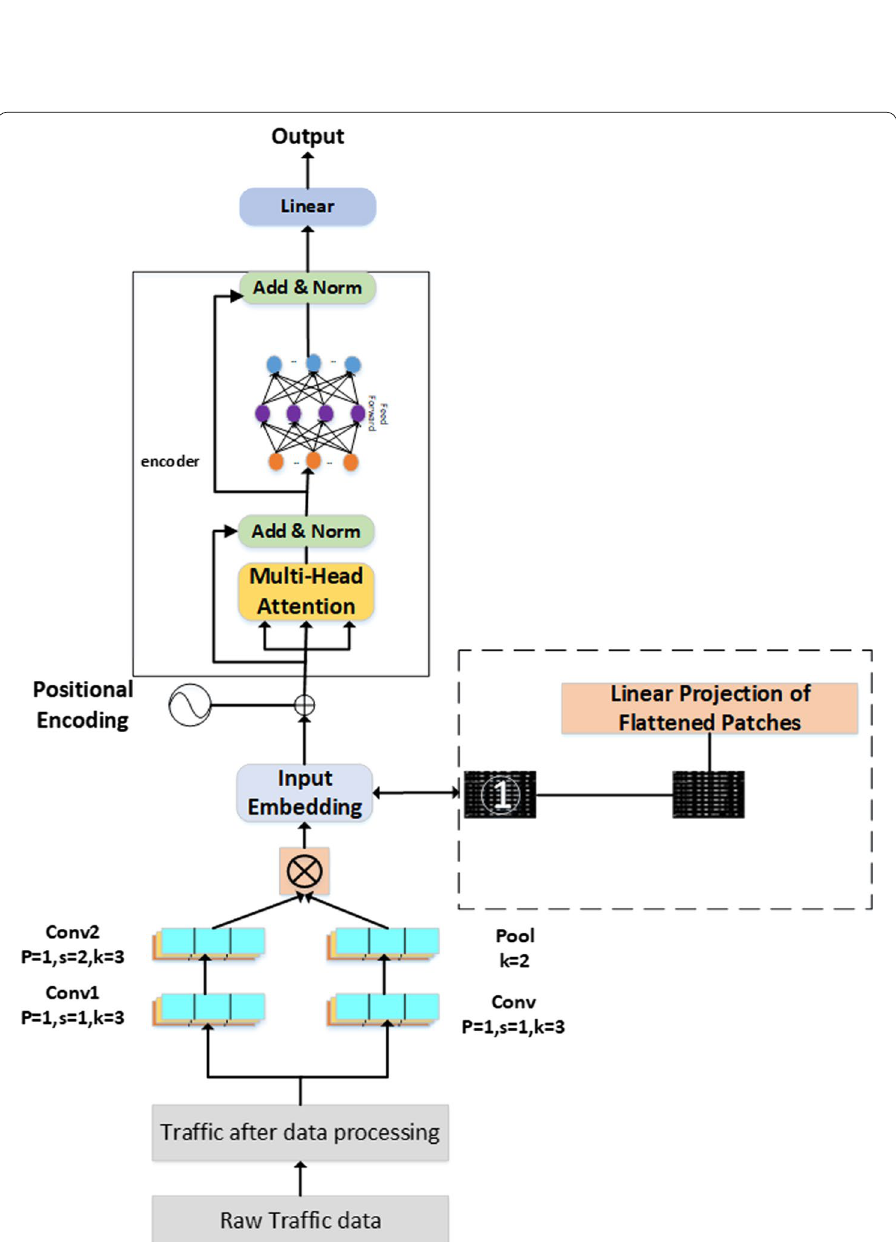
Fig. 3 MFVT’s overall